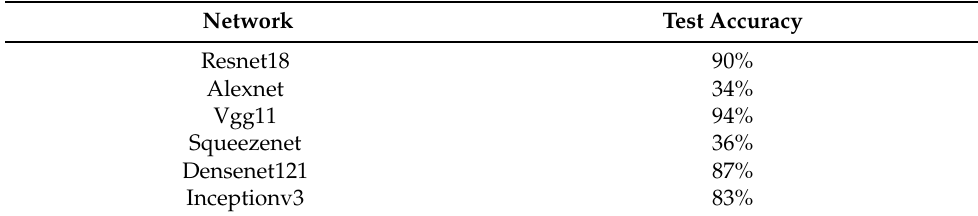
Table 5. Initial CNN architecture test results, trained on C1.